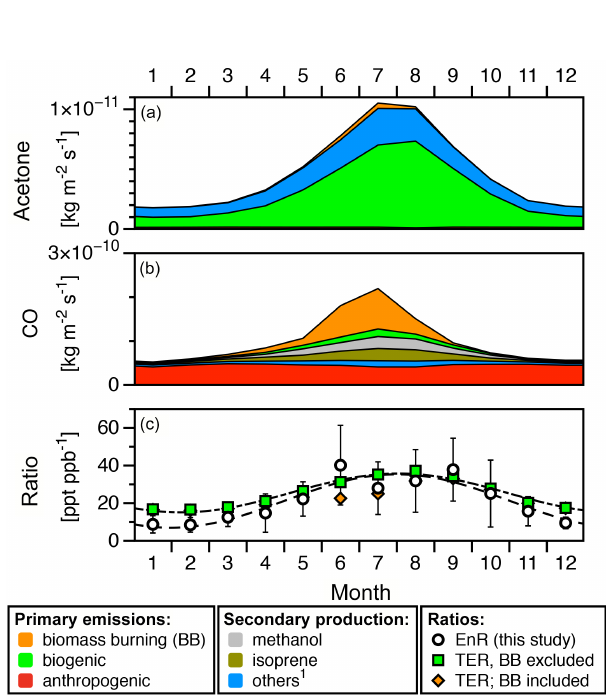
Figure 10. North American emission rates of (a) acetone and (b) CO according to the ECCAD inventory database, averaged over the time period 2005–2010. (c) Mean EnRs derived from IAGOS– CARIBIC measurements are compared to ECCAD total emissions volume ratios (TERs) of acetone and CO with and without consid- eration of biomass burning (BB). The dashed lines show sinusoidal functions fitted to the monthly means of EnR and TER (biomass burning excluded). 1 Includes propane, isobutane, isopentane, seven monoterpene species and methylbutenol as precursors of acetone and ethene, ( ≥ C 4 ) alkanes, ( ≥ C 3 ) alkenes and monoterpenes as precursors of